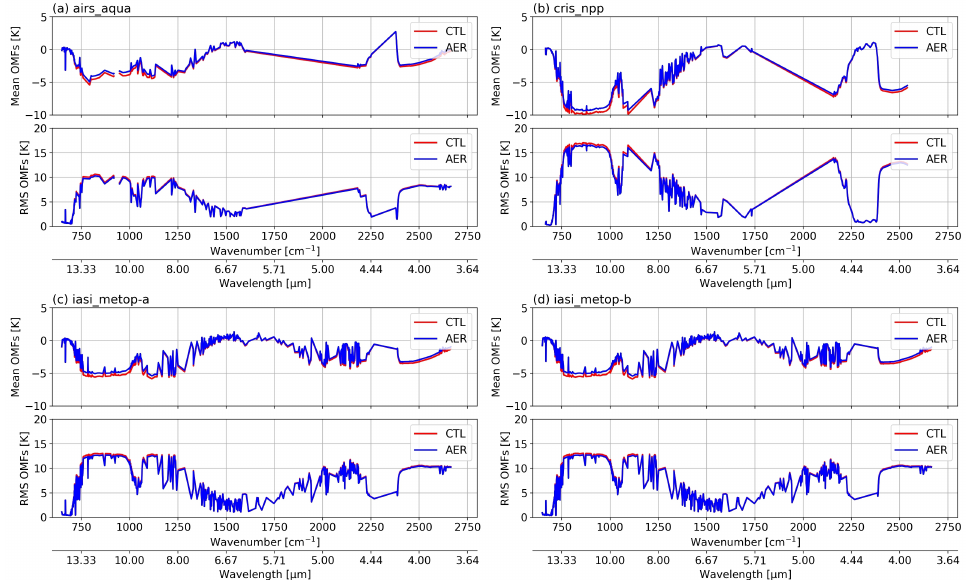
Figure 6. Mean OMFs (upper panel in each) and RMS OMFs (lower panel in each) before BC and QC on ( a ) AIRS on Aqua ( b ) CrIS on Suomi-NPP ( c ) IASI on MetOp-A and ( d ) IASI on MetOp-B averaged along analysis cycles during 1–28 August 2017. Results of CTL and AER are presented in red and blue, respectively.